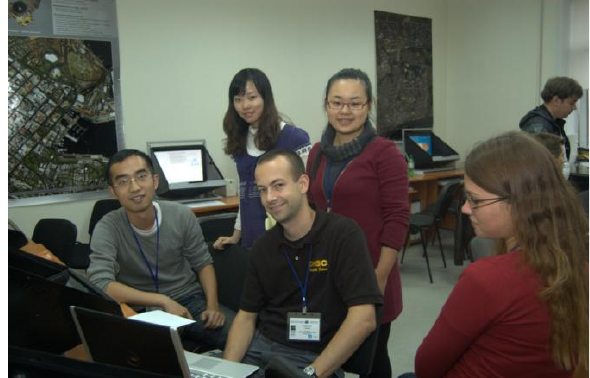
Figure 1. Practical studies in a lab